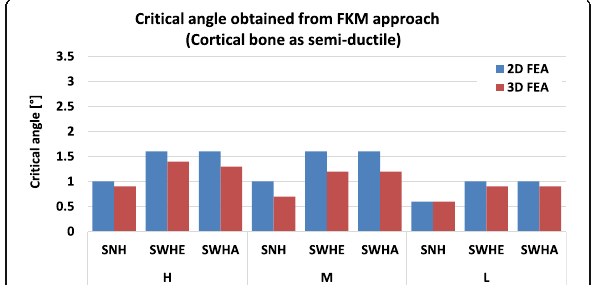
Fig. 14 Critical angle obtained using FKM approach (Cortical bone as semi-ductile): The critical angle was the angle obtained when the equivalent stress in the specimen reached the assessed static strength. The higher critical angles were obtained for specimens with drilled holes (SWHE and SWHA)